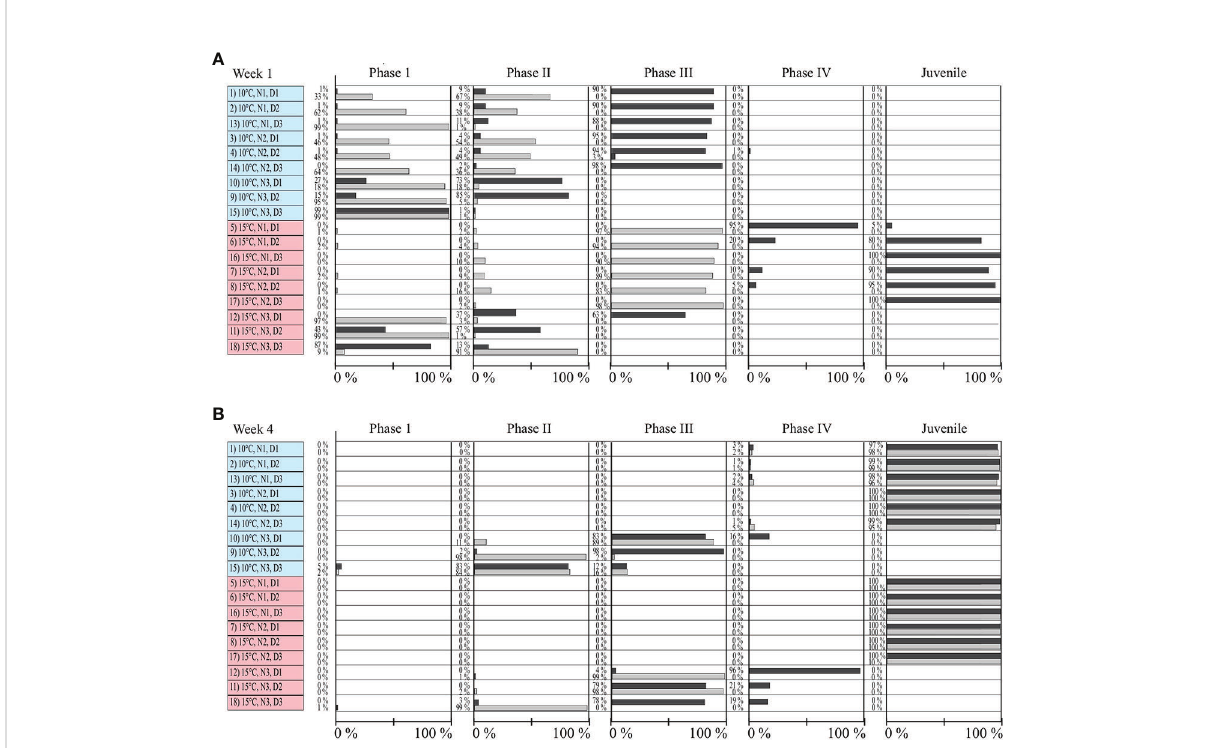
FIGURE 2 Development rate of early ontogenetic stages of clonal (light grey) and recombinant (dark grey) gametophyes of Ulva fenestarata under different environmental conditions (10°C and 15°C, N1 = PES, N2 = 3xPES, N3 = SW, D1 = 10 000 swarmers ml -1 , D2 = 5000 swarmers ml -1 and D3 = 500 swarmers ml -1 , for further explanations see text). Given is the amount (in %) of individuals in the respective ontogenetic development phase after (A) 1 week and (B) 4 weeks (for full data see also Supplementary Figure S1